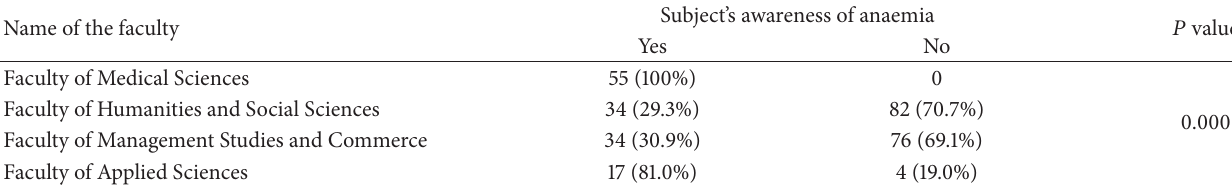
Table 2: Subjects’ awareness on anaemia according to the faculty in which they are studying.